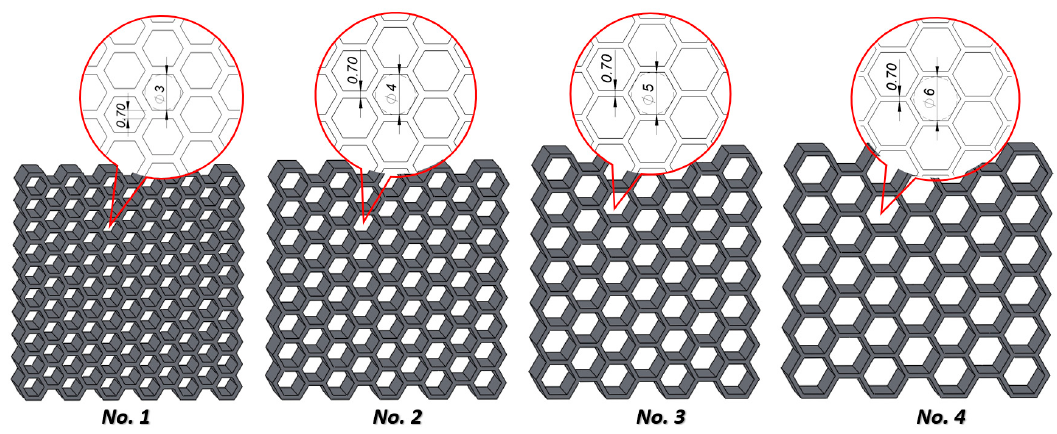
Figure 2. Four variants with of thin-walled honeycomb structures differing in the size of the cells (No. 1 - No. 4, dimensions in mm). Table 1. Relative density of the developed honeycomb structures.